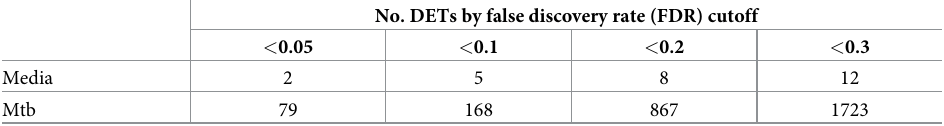
Table 1. RSTR versus LTBI differentially expressed transcripts (DETs), Mtb condition.